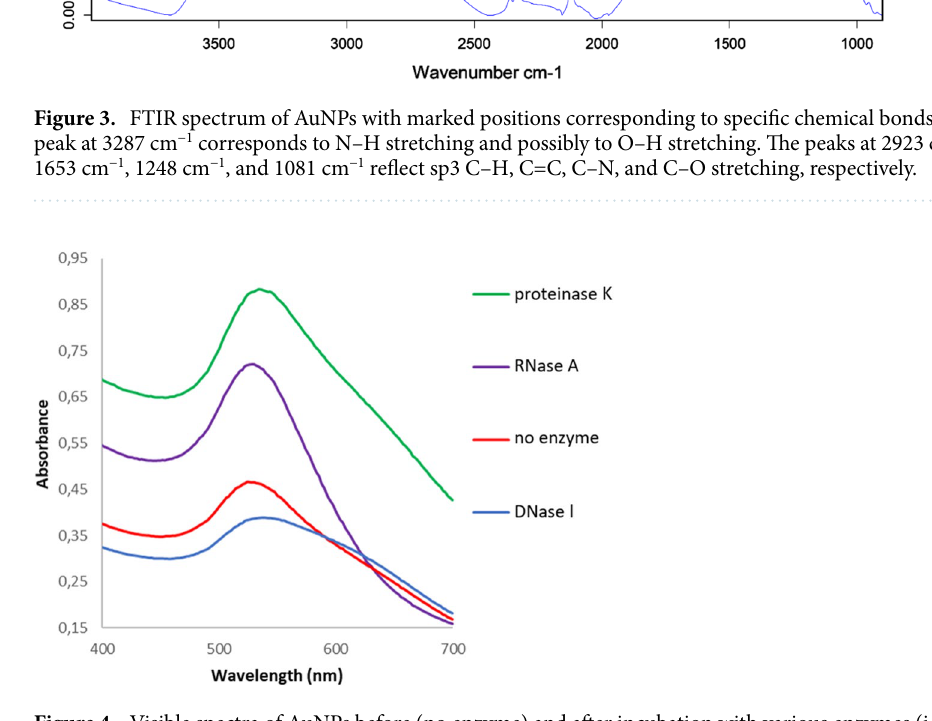
Figure 4. Visible spectra of AuNPs before (no enzyme) and after incubation with various enzymes (i.e., proteinase K, RNase A and DNase I).